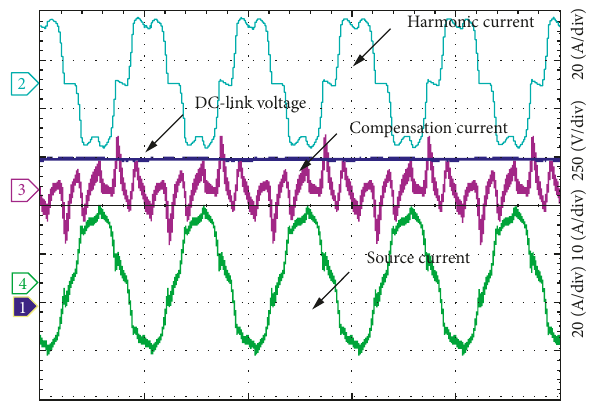
Figure 21: Experimental steady waves using PI controller.